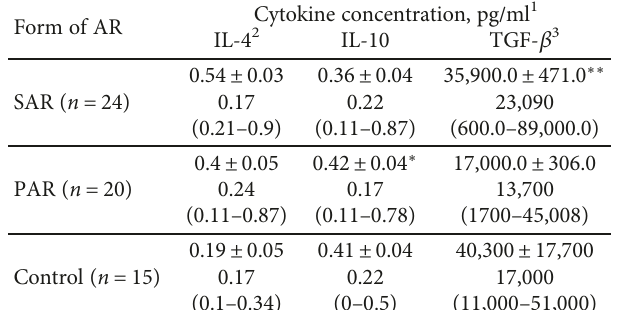
Table 6: Serum cytokines in allergic